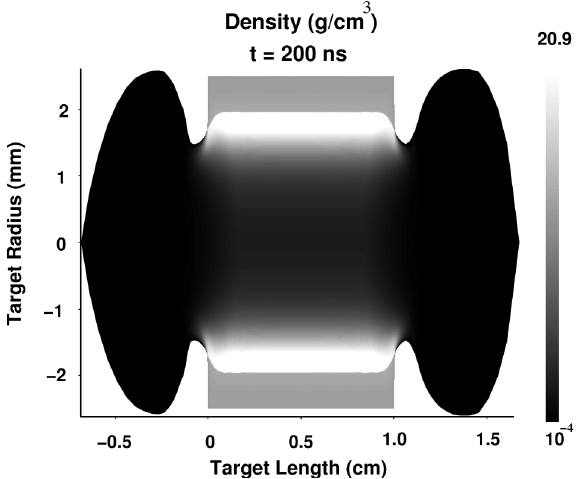
FIG. 9. Density at t (cid:3) 200 ns corresponding to the case shown in Fig. 5.